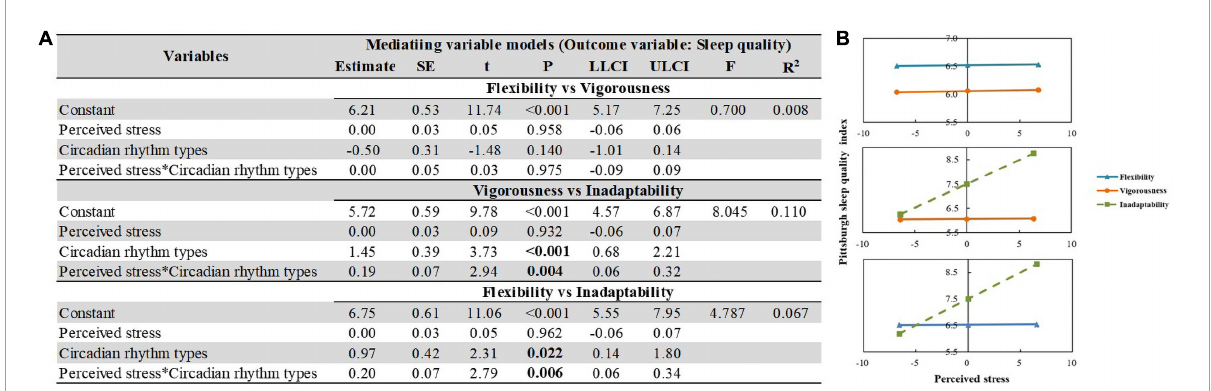
FIGURE6 The moderating effect of circadian rhythm types between perceived stress and sleep quality. (A) Moderating role of circadian rhythm types in the association between perceived stress and sleep quantity. Regularity of diet was adjusted for each model. Independent variables were centered before analysis. (B) Simple slope plot of the interaction between circadian rhythm types and perceived stress on sleep